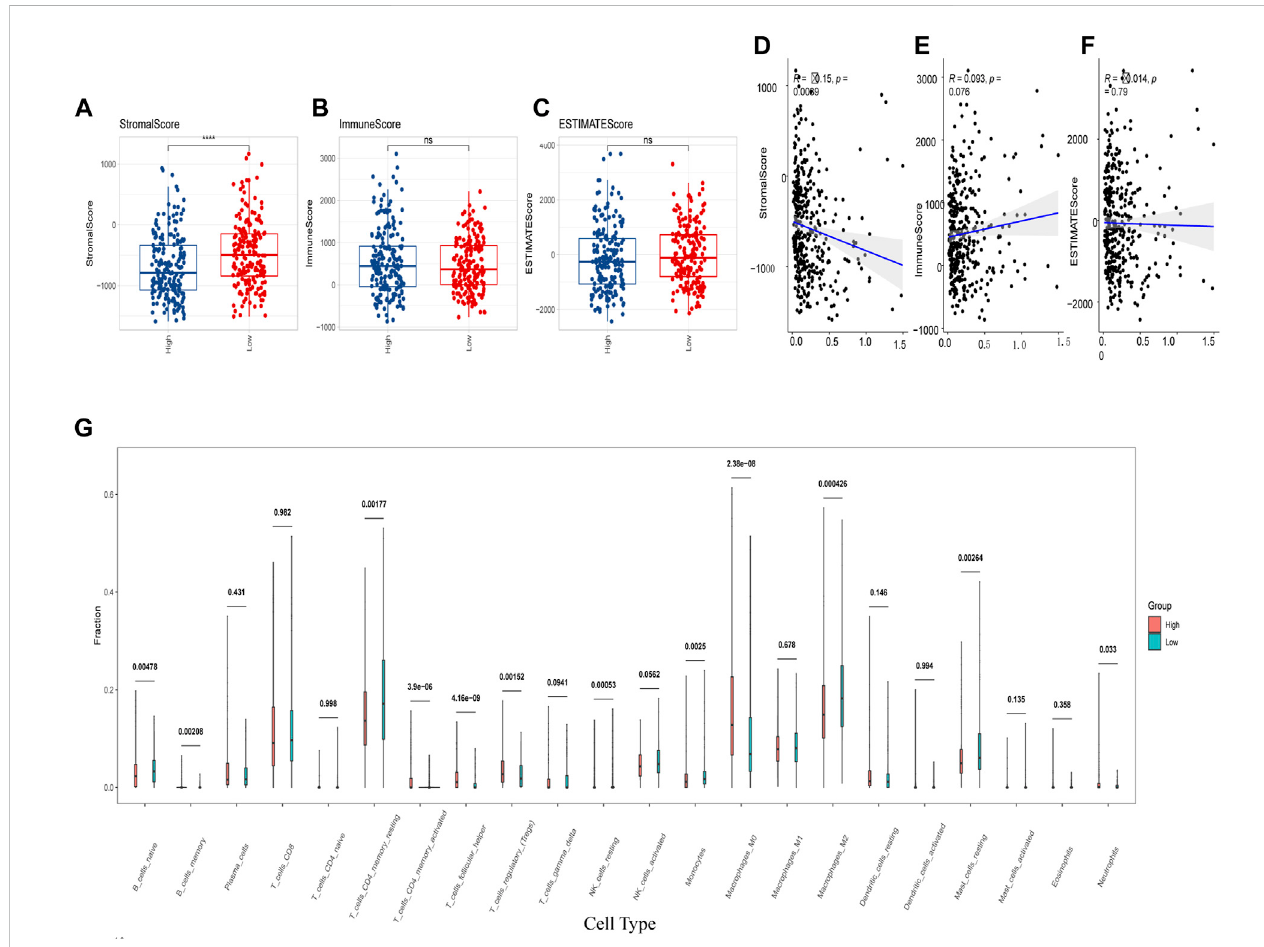
FIGURE 9 Cuproptosis-related genes (CRGs) signature was correlated with immune score and immune in fi ltrating cells. (A – C) Differences of matrix score (A) , immunescore (B) andESTIMATEscore (C) betweenthetwogroupswithhighandlowCRGssignature; (D – F) CorrelationsofCRGssignatureandmatrixscore (D) , immune score (E) and ESTIMATE score (F) ; (G) Differences inimmune cell score between two CRGs groups with highand low CRGs signature(calculated by Cibersort) (ns: p > 0.05; ****: p <